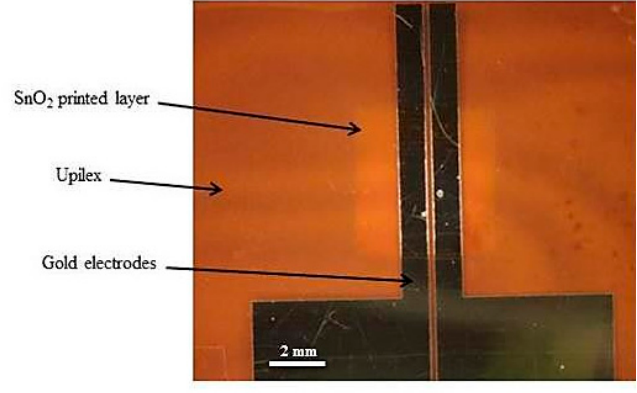
Figure 2. Sensor layout observed by binocular